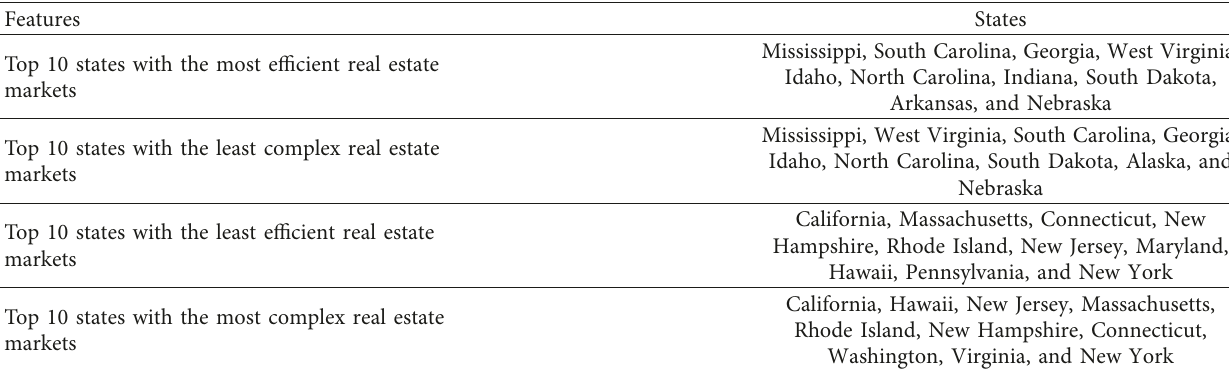
Figure 7: Complexity-entropy binary causal plane of American real estate market. Table 4: Top 10 states in four extreme cases in American